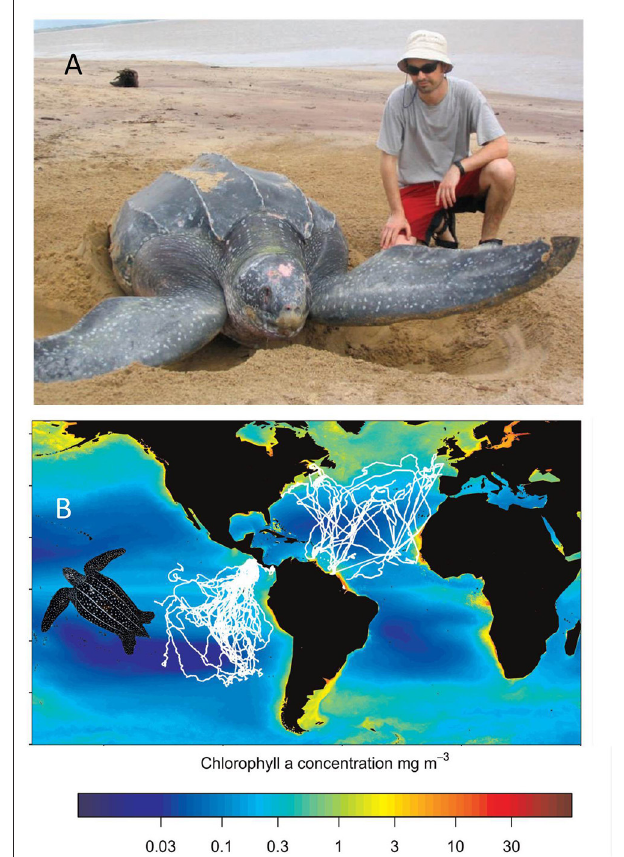
FIGURE 4 | The value of collaborative studies that pool tracking data (A) . The leatherback turtle ( Dermochelys coriacea ) is the largest species of sea turtle, nesting on tropical and sub-tropical beaches but then traveling extensively across ocean basins in search of its jellyfish prey. In the eastern Pacific leatherback turtles are listed as “Critically Endangered” (i.e., on the verge of extinction) while in the North Atlantic their conservation status is listed as “Least Concern” (http://www.iucnredlist.org) (photo credit and informed consent: Tom Doyle) (B) . The tracks of 77 leatherback turtles tracked in the eastern Pacific and North Atlantic. Different movement patterns between these two ocean basins indicate higher foraging success for individuals in the Atlantic, which may be linked to their higher reproductive output and healthier conservation status. Modified with permission from Bailey et al. (2012).